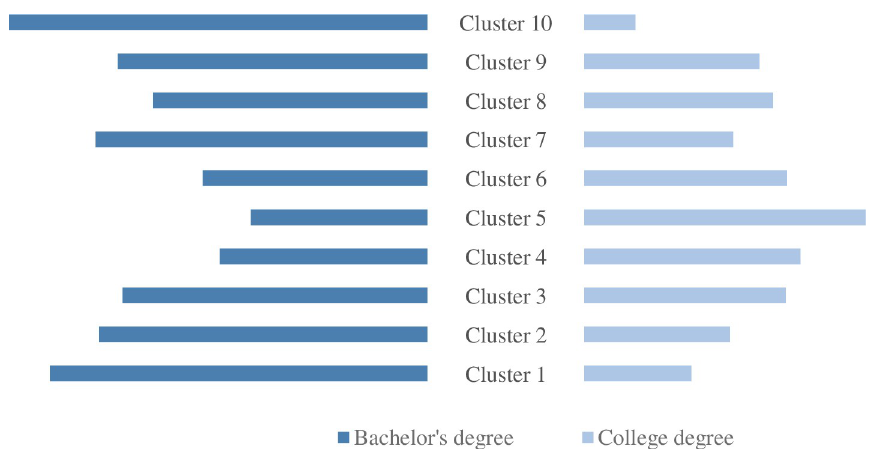
Fig 4. Comparison of requirements for undergraduate and junior college degrees of various positions.